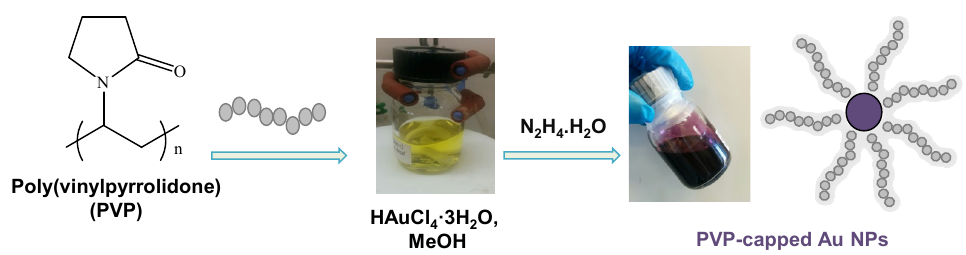
Figure 1. Schematic presentation of the synthetic pathway followed for the generation of highly stable polyvinylpyrrolidone (PVP)/Au colloidal nanohybrid solutions prepared in MeOH and corresponding photographs.